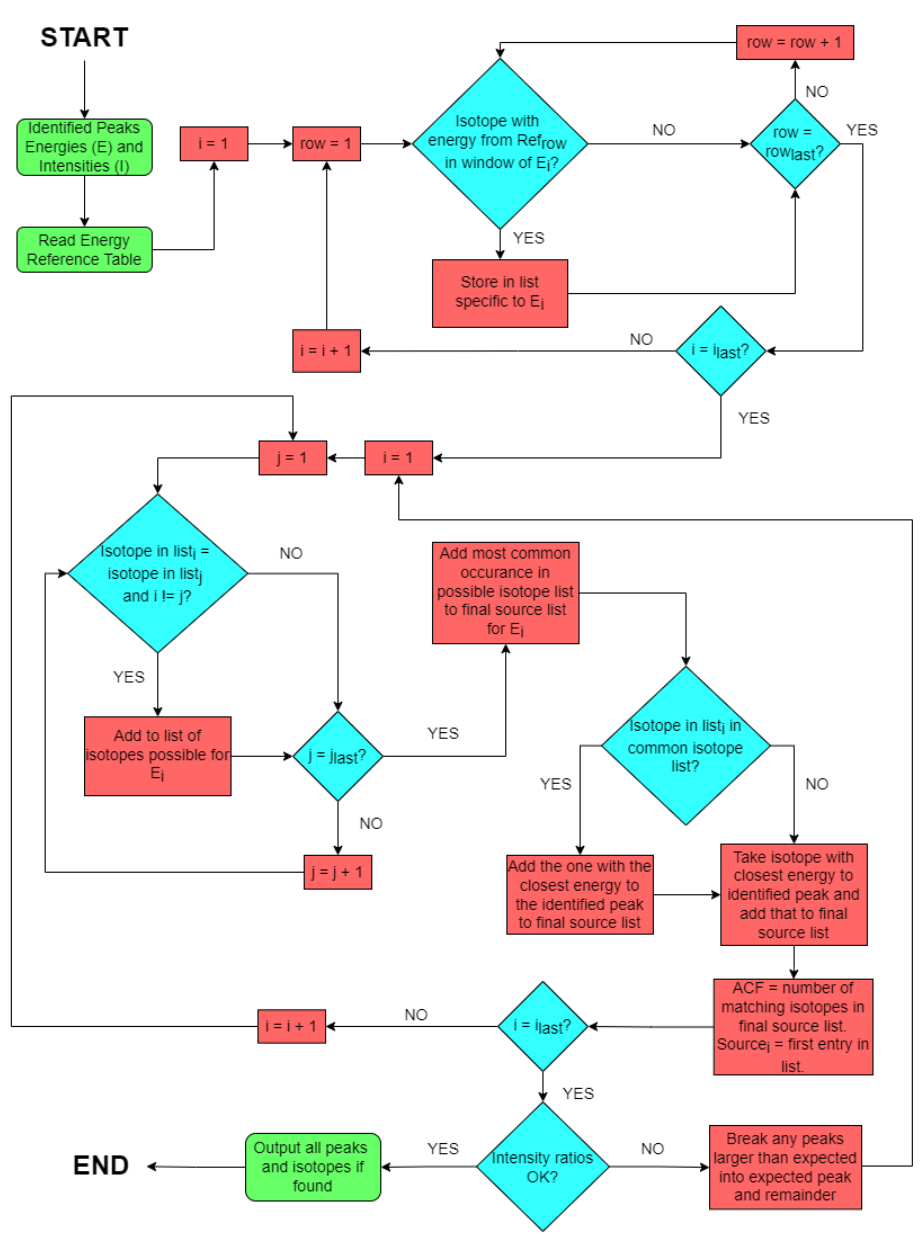
Figure 4. Flowchart for isotope identification process within the